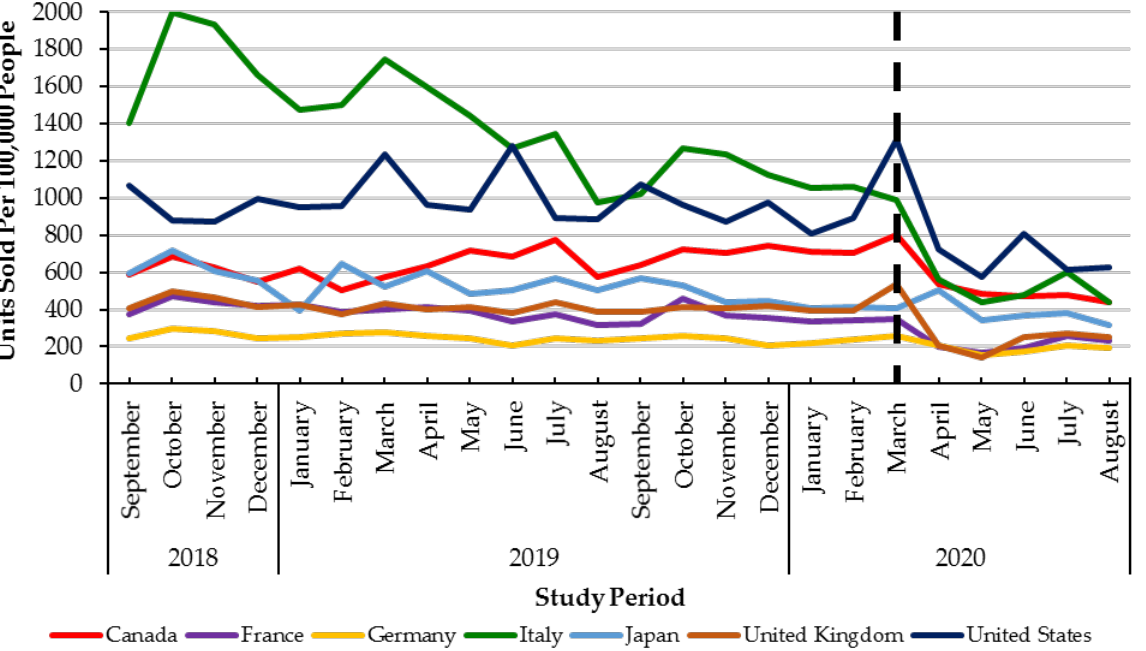
Table 1. Results of interrupted time-series model examining the impact of the COVID-19 pandemic on Direct Acting. Antiviral utilization across the G7 countries.